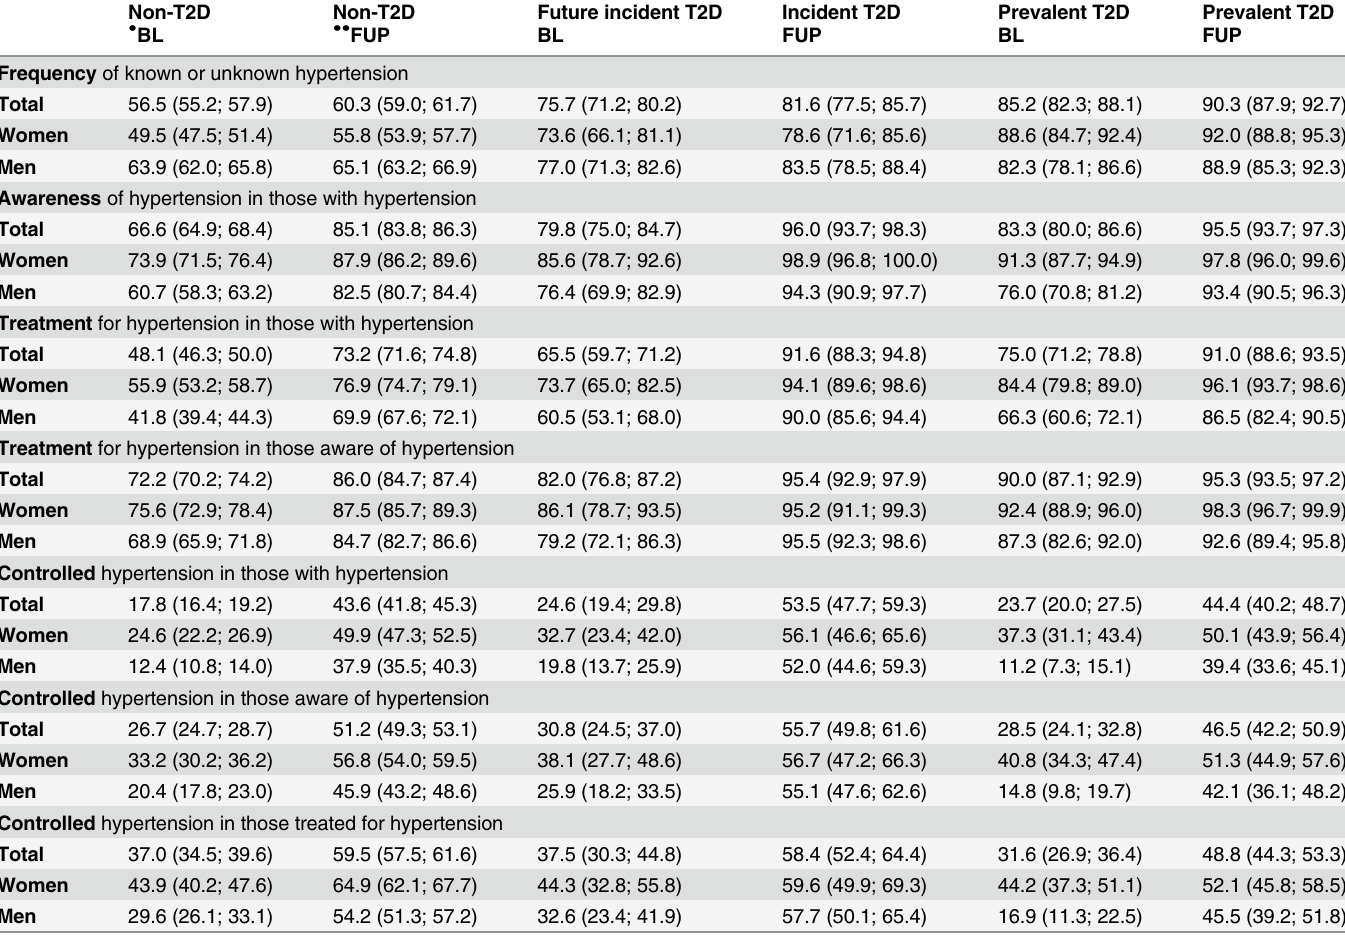
Table 2. Degrees of awareness, treatment, and control at baseline and follow-up, stratified by T2D status and